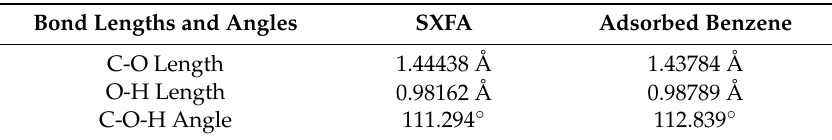
Table 2. Bond Length and Valence Angles of the